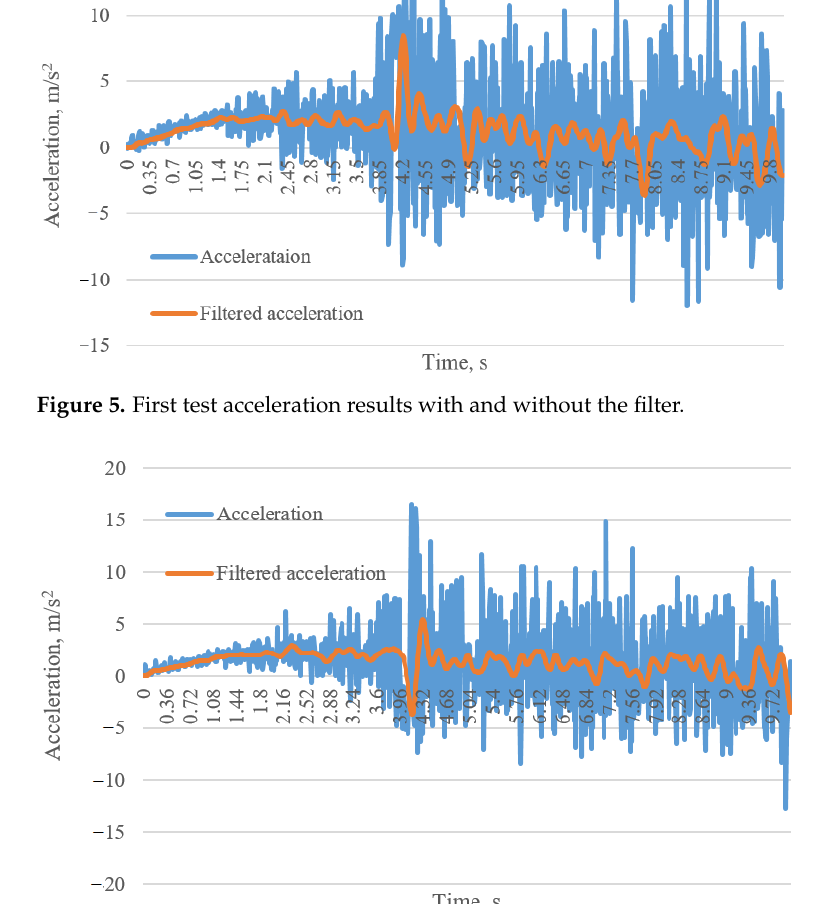
Figure 8. Second test ’s acceleration results compared with calculated results. The calculated accelerations, presented in Figures 7 and 8, were converted similarly for these time periods as those mentioned above according to the synchronized data: 1.31 – 2.34 s — 2.19 m/s 2 ; 2.35 – 3.38 s — 2.18 m/s 2 ; 3.39 – 4.42 s — 2.17 m/s 2 ; 4.43 – 5.46 s — 2.15 m/s 2 ; 5.47 – 6.50 s — 2.1 m/s 2 ; 6.51 – 7.54 s — 1.73 m/s 2 ; 7.55 – 8.58 s — 1.58 m/s 2 . The time period after 4.5 s is visible; according to the compared data, the difference between the calculated and the measured data is growing, and experiment on the test drive should be repeated, or accepted, because the difference between the measured and calculated data is approximately 0.5 m/s 2 . 3. Results and Discussion The presented determination and evaluation of the three-wheeled tilting vehicle made by the AKO team reveals dynamic characteristics that can help to improve future versions of it, especially versions using other electric motors and a control algorithm. Using a three-wheeled vehicle scaled-down model (1:16) and a wind tunnel, the drag coefficient ( K = 0.102) was determined experimentally, which was used for the dynamic calculations. The vehicle max speed ( v max = 24.83 m/s) and range of acceleration, which varied from 2.19 m/s 2 to 1.58 m/s 2 , were obtained according to three-wheeled tilting vehicle body’s di- mensions and the electric motor (HPM-2000) used.